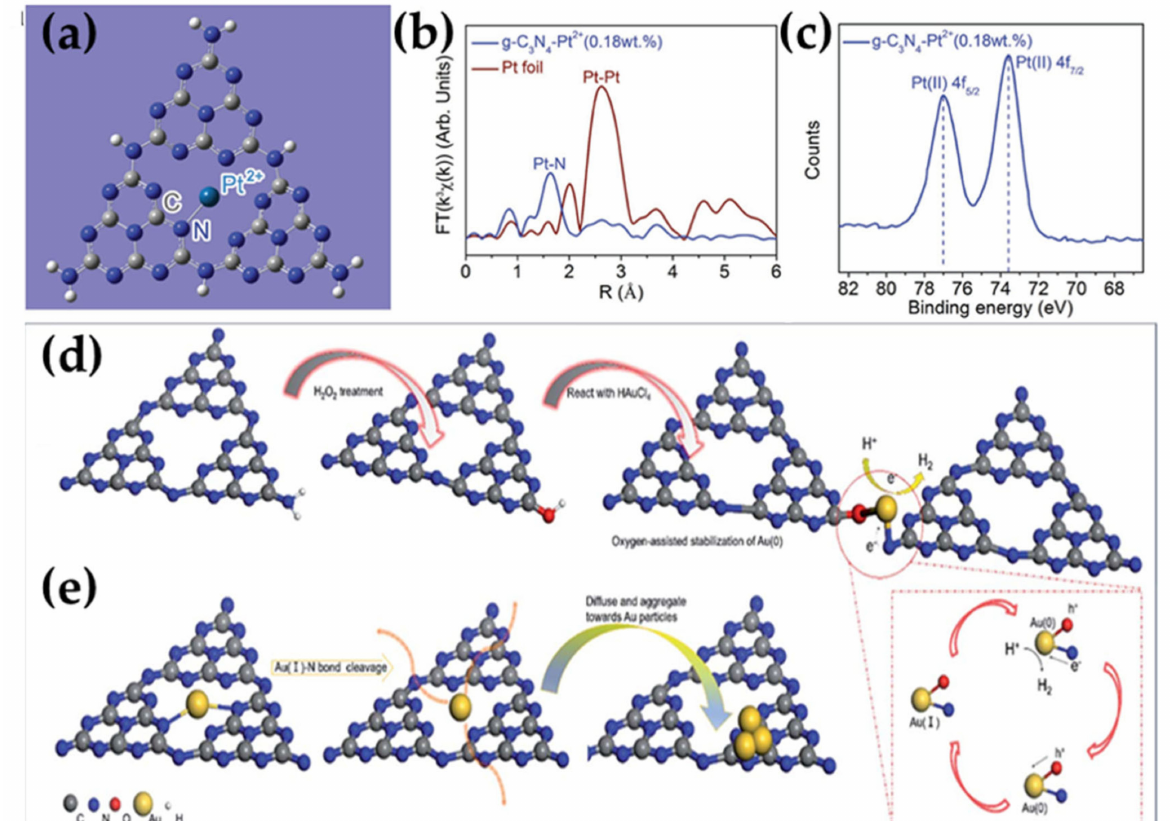
Figure 3. ( a ) Structural illustration for the coordination of g-C 3 N 4 with Pt 2+ [54]; ( b ) k 3 -weighted Fourier-transform Pt L 3 -edge EXAFS spectra for g-C 3 N 4 -Pt 2+ (0.18 wt%) in reference to Pt foil (no phase corrected) [54]; ( c ) XPS Pt 4f spectrum of g-C 3 N 4 -Pt 2+ (0.18 wt%) [54]; ( d ) Schematic of the structural evolution of CNUHAu during photocatalytic reactions [55]; ( e ) schematic of the structural evolution of CNUAu during photocatalytic reactions